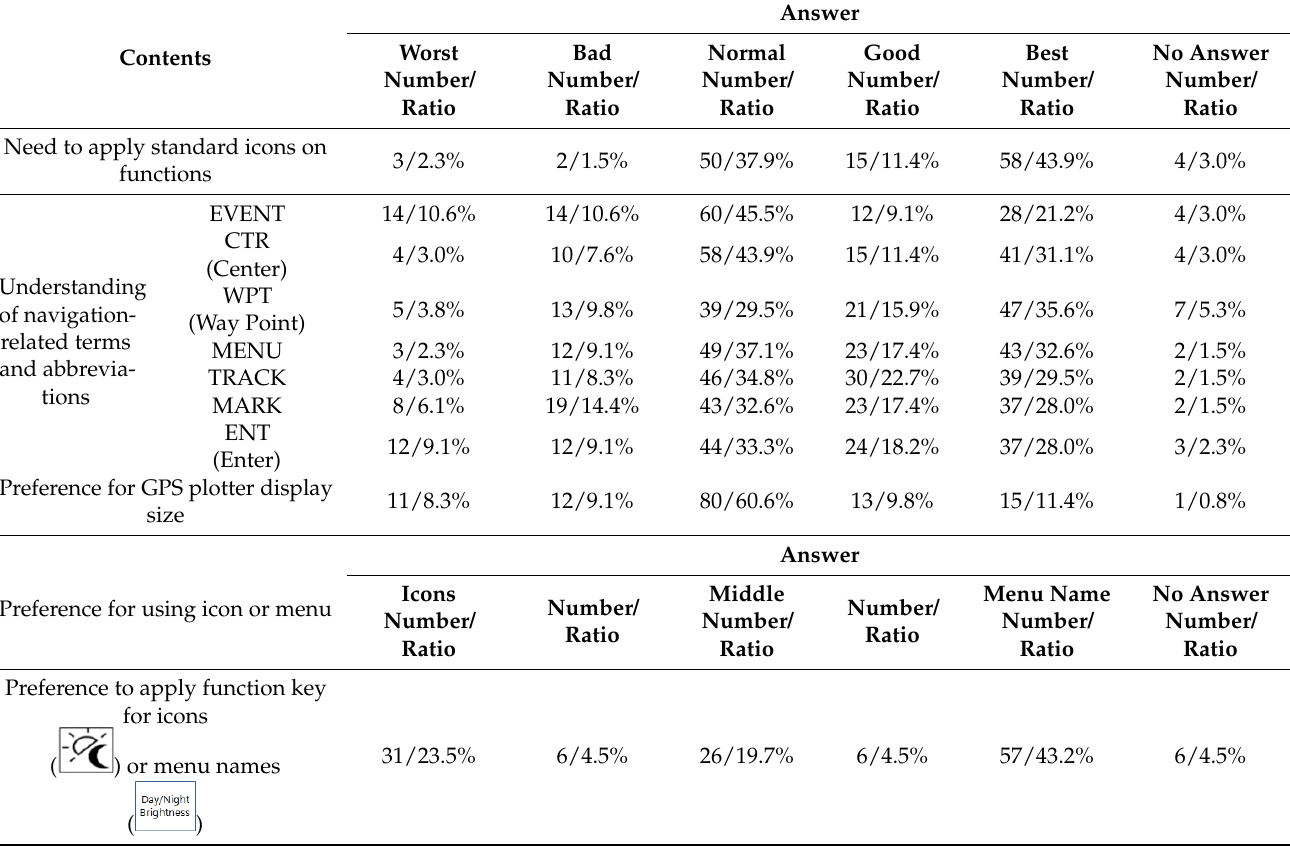
Table 5. Overall results of the user survey on the preference of icon application and understanding of navigational terms on the GPS plotter.